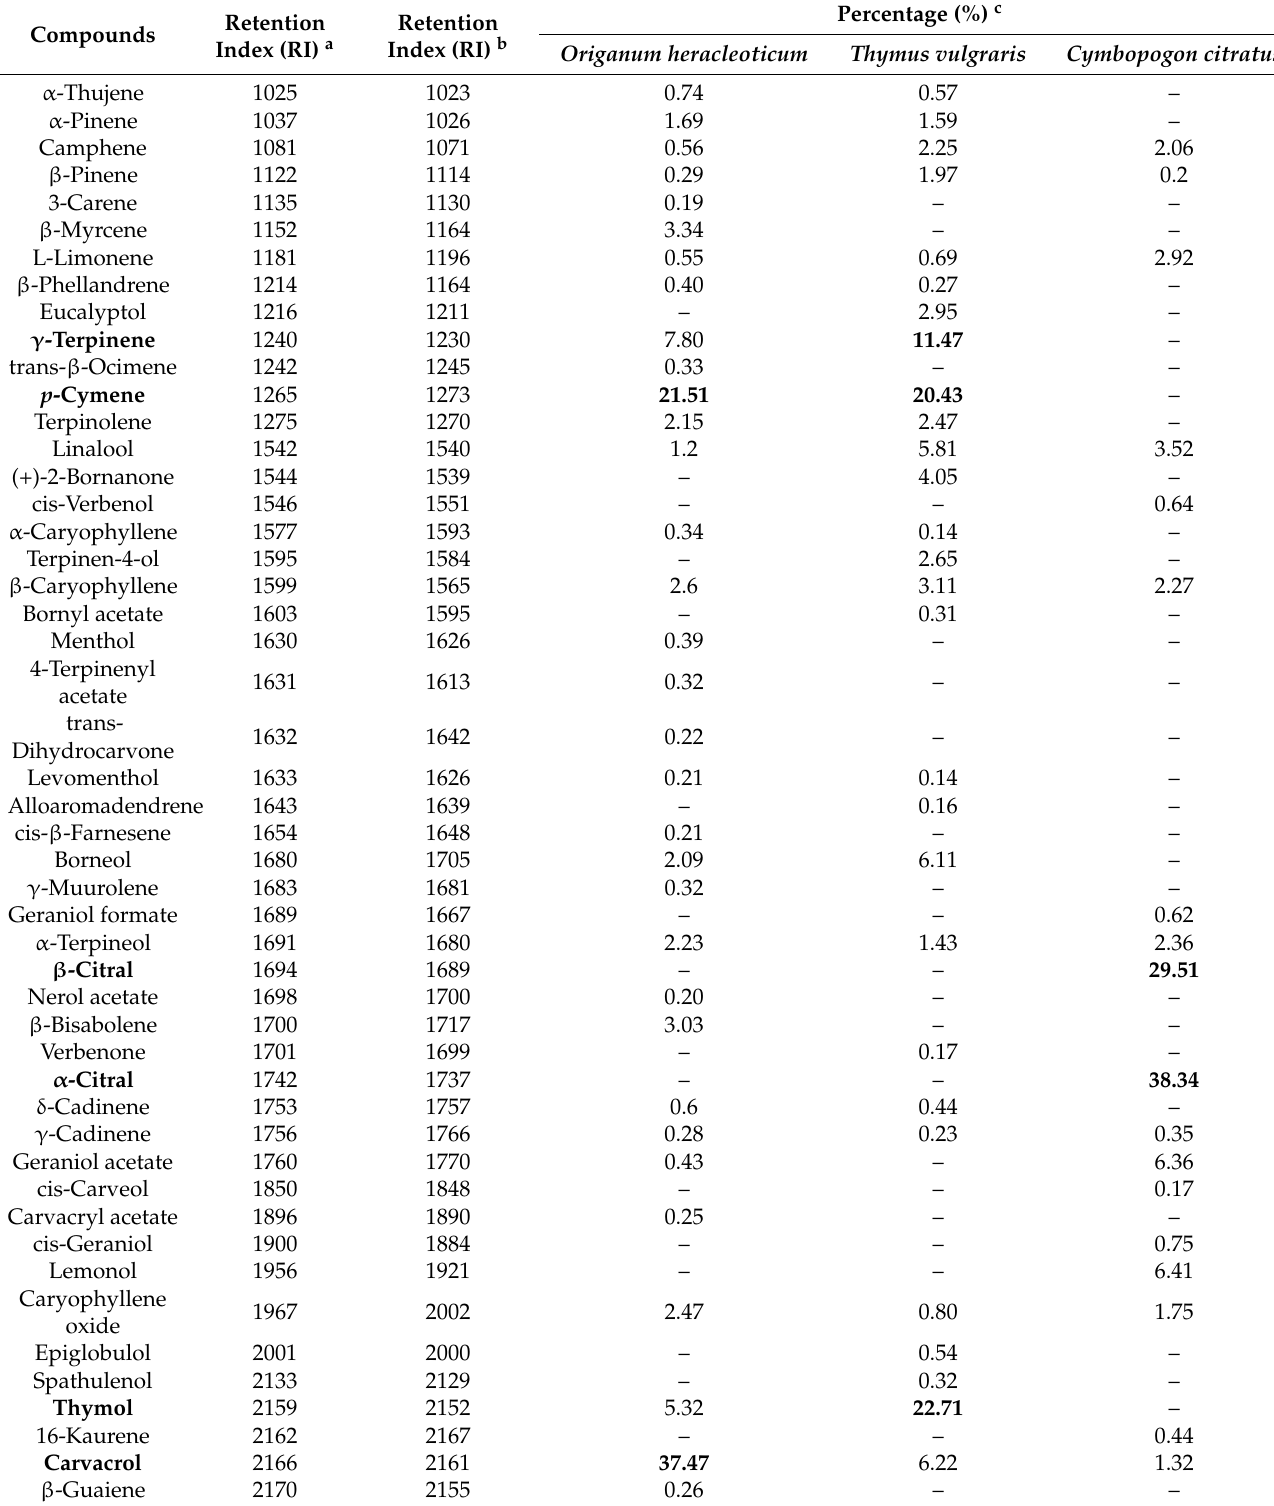
Table 2. Chemical composition of essential oils from Cymbopogon citratus ( Cc ), Thymus vulgraris ( Tv ), and Origanum heracleoticum ( Oh